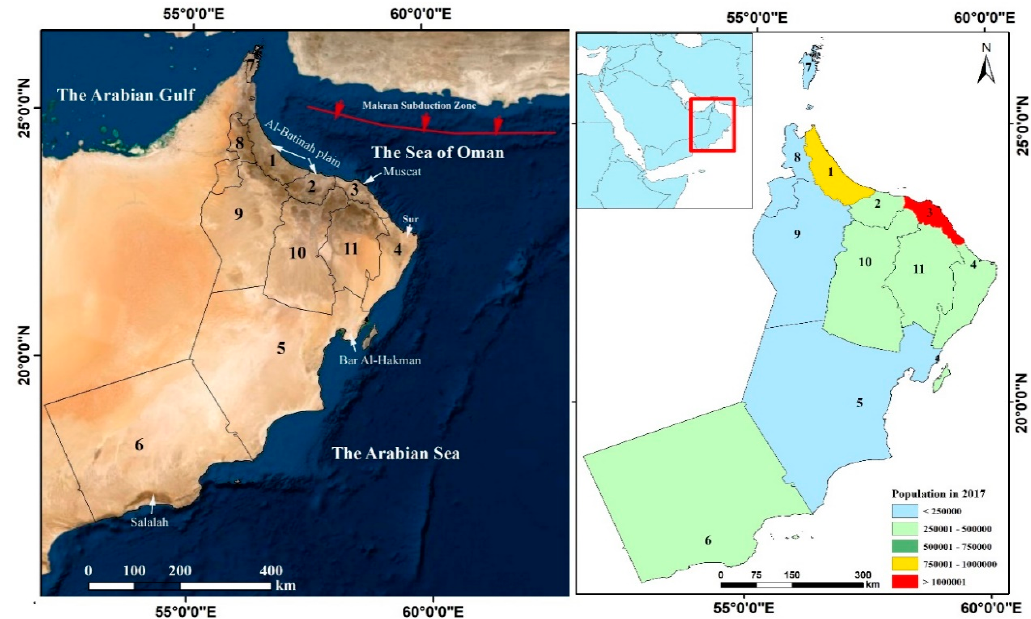
Figure 1. The location of Oman along the three water bodies. Note the shallow continental shelf of the country. Source. Google Earth maps. The numbers refer to coastal governorates of the country: 1— Batinah North; 2—Al-Batinah South; 3—Muscat; 4—Ash Sharqiya South; 5—Al-Wusta; 6—Dhofar; The Al-Batinah plain includes #1 and #2. The right map shows the the population of Oman in 2017 [45].